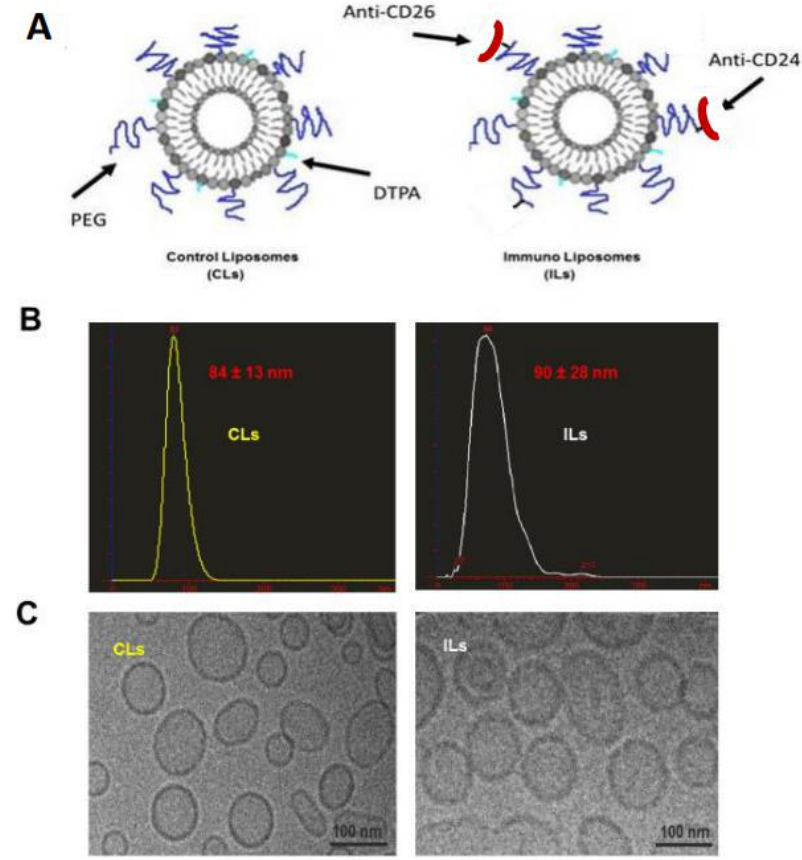
Figure 6. Formulation and characterization of CLs and ILs. ( A ) To obtain ILs, the reduced mABs (CD26 and CD24) were conjugated to Mal-PEG-DSPE first and the resultant conjugates, DSPE- PEG 2000 -CD26 and DSPE-PEG 2000 -CD24, were inserted onto liposomes through a post-insertion method as described in the Materials and Methods section. ( B ) The size distribution of CLs and ILs were measured by LM10 nanoparticle tracking system. ( C ) Cryo-electron micrograph of CLs and ILs. Particles are predominantly spherical and consist of subpopulations with different diameters. Scale bar: 100